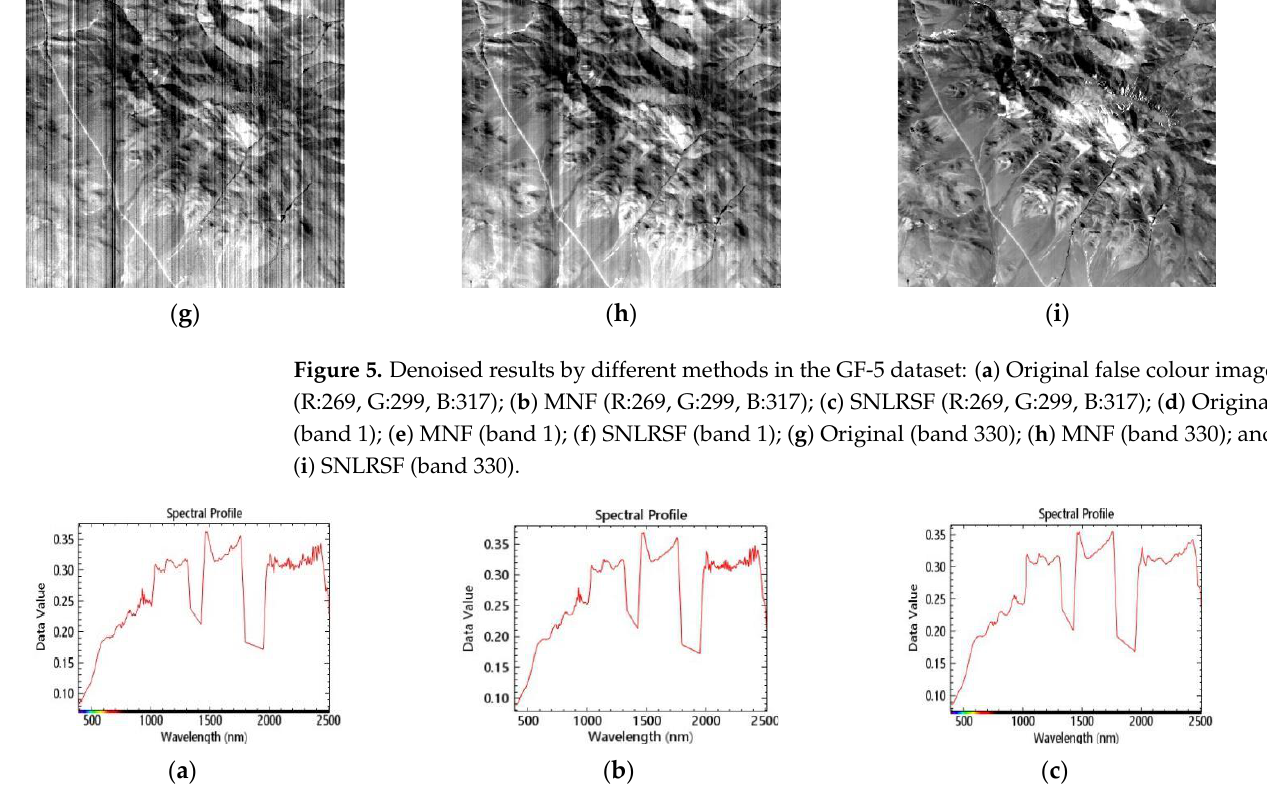
Figure 5. Denoised results by different methods in the GF-5 dataset: ( a ) Original false colour image